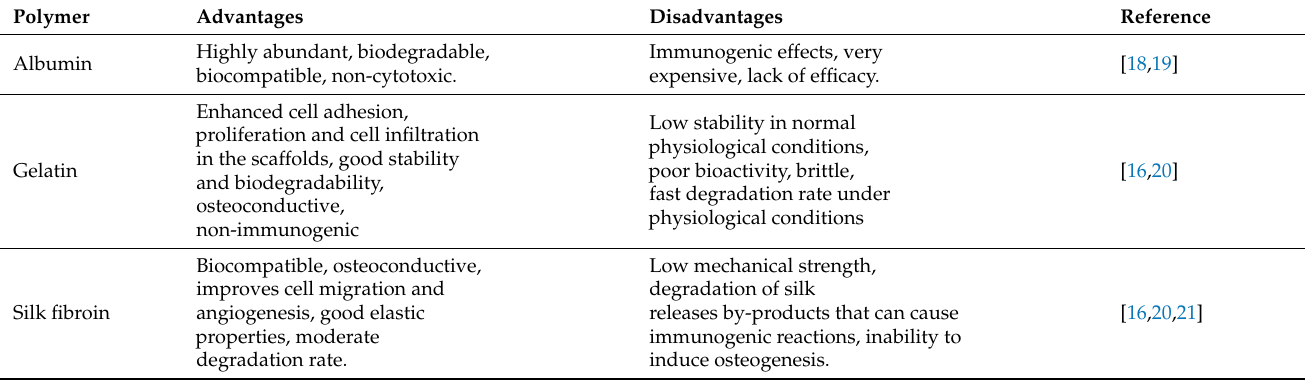
Table 1. Summary of advantages and disadvantages of various biopolymeric